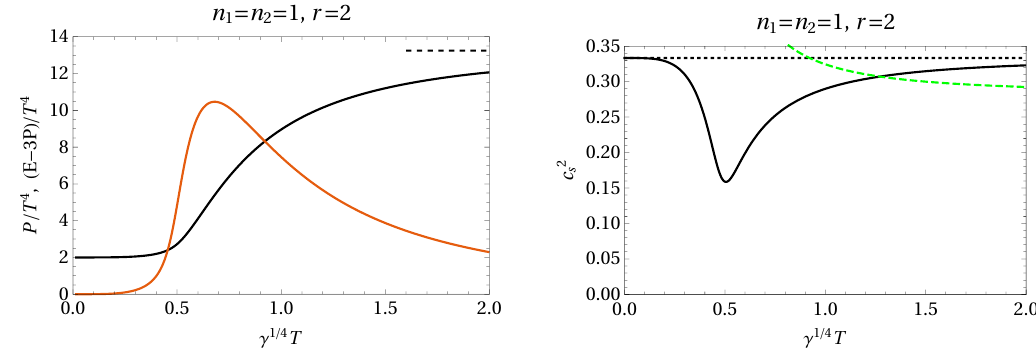
Figure 3 . Left panel: pressure (black line) and trace of the energy-momentum tensor (red) divided by T 4 , with the asymptotic value of the pressure indicated by the short dashed line; right panel: speed of sound squared (full black line) | both for n 1 = n 2 = 1 and r = 2. As (cid:13) 1 = 4 T increases from small to large values, a crossover between regimes with di(cid:11)erent values of P = T 4 takes place that is accompanied by a dip in the speed of sound which takes on a conformal value in both asymptotic regimes. At large (cid:13) 1 = 4 T and for su(cid:14)ciently low values of r (including the case r = 2 at hand), the speed of sound in the full system turns out to be larger than the e(cid:11)ective lightcone speed v of the subsystems (green dashed line: v 2